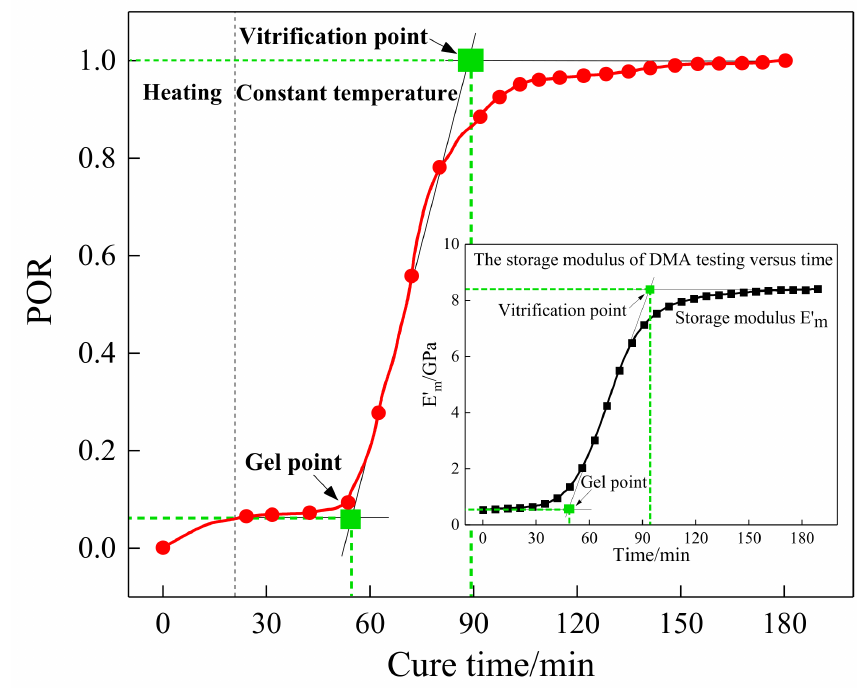
Figure 12. The POR curve of the sensing path P4s_6s for the quasi-isotropic specimen.